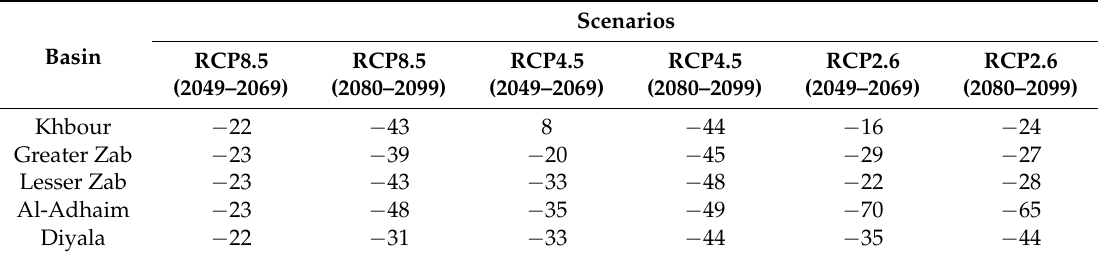
Table 7. The projected relative changes in blue water for the five basins under RCP8.5, RCP4.5, and